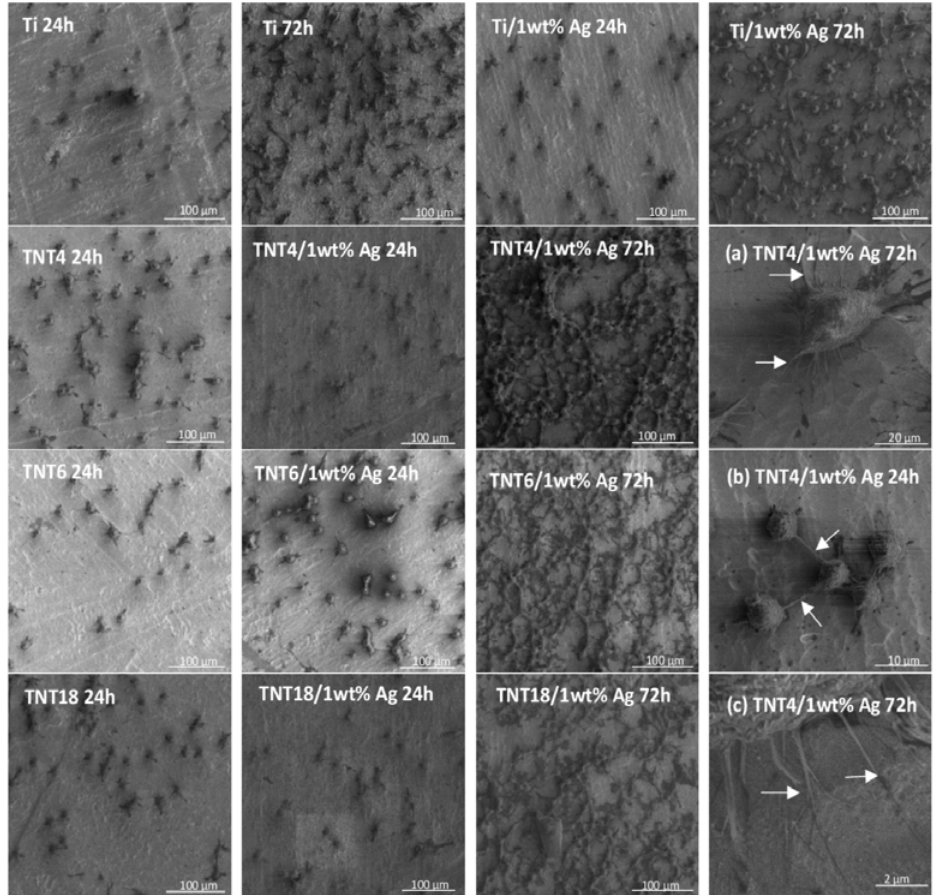
Figure 5. Results of SEM studies of the L929 murine fibroblasts adhesion (24 h) and proliferation (72 h) on the titanium substrate (Ti) ; titanium substrate deposited by silver nanoparticles (Ti/1 wt% Ag); and TNT4, TNT6 , and TNT18 coatings loaded or not loaded with silver nanoparticles (TNT/Ag, and TNT, respectively). The arrows in Figure 5 a – c indicate the filopodia spread between fibroblast ( b ) and the filopodia which attached the cells to the TNT4/1wt% Ag coating’s surface ( a , c ).